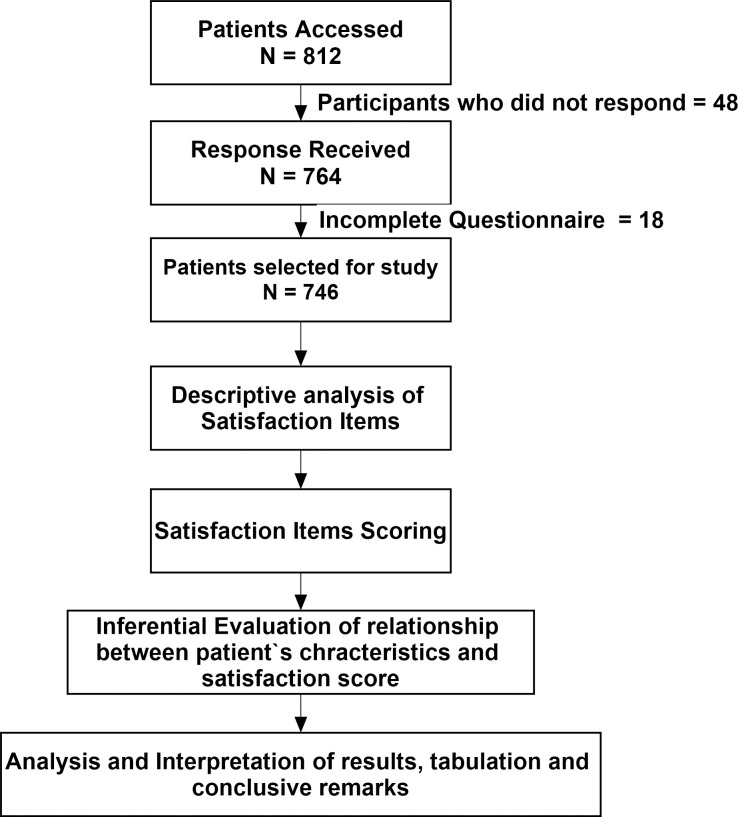
Study flow diagram.